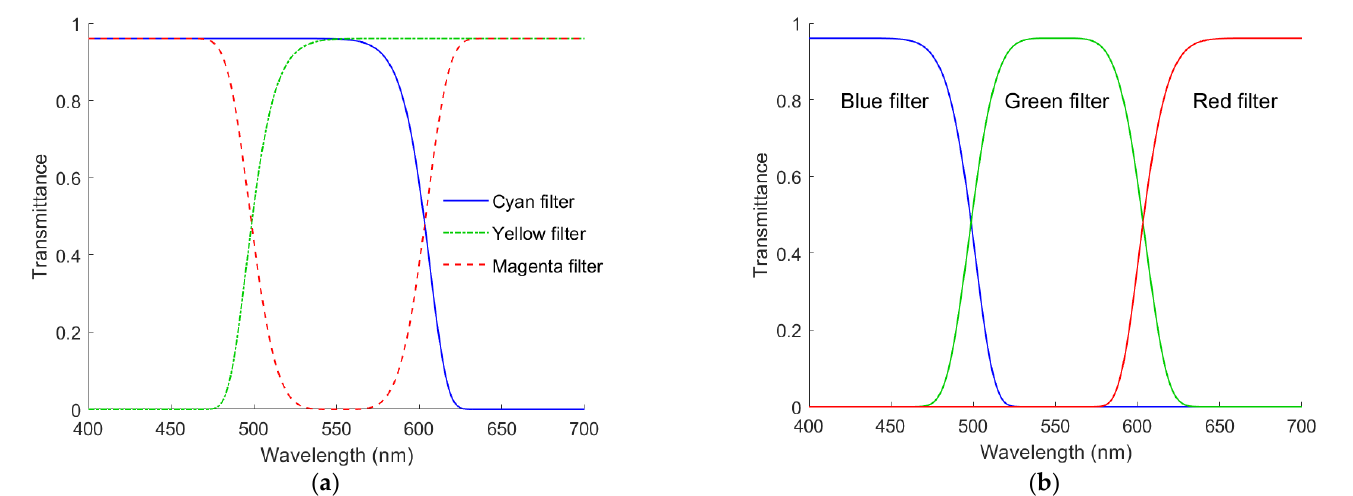
Figure 6. Spectral transmittance of the ( a ) cyan, yellow, magenta, ( b ) red, green and blue filters for creating ARSs. Refer to Section 3.3 for details.